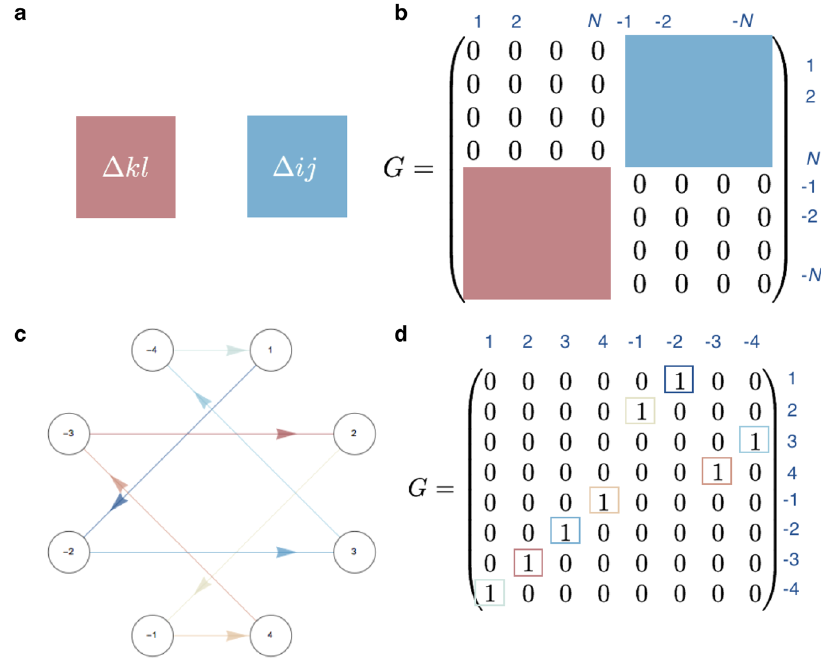
Fig. 6 | The directed graph representation of a general cascaded-mode reso- nator.a Aschematicofthemodeconversionsinacascaded-moderesonator. b The adjacency matrix of this cascaded mode resonator contains two symmetric sub- matricesthatcorrespondtotheleftandrightmodeconverters. c Anexampleofthe